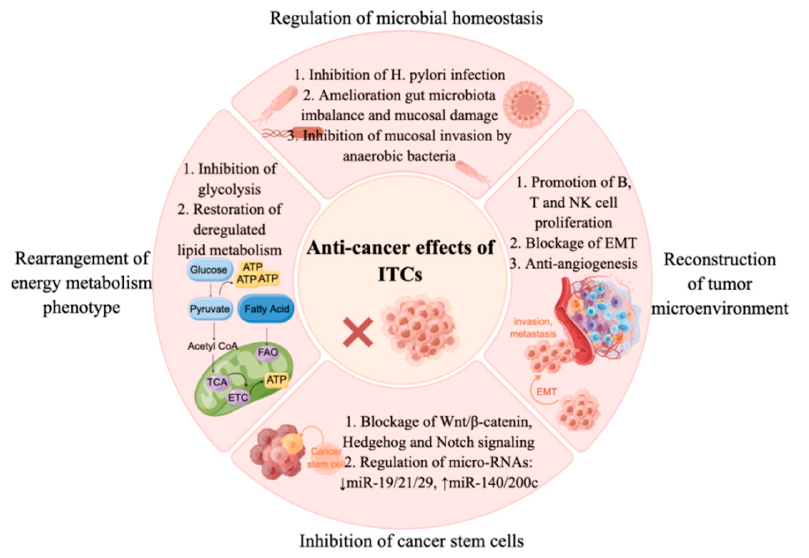
Figure 1. Multiple mechanisms of isothiocyanates in cancer prevention and therapy. ITCs inhibit cancers through regulating microbial homeostasis, such as inhibiting H. pylori infection, ameliorating gut microbiota imbalances and mucosal damage, and inhibiting mucosal invasion by anaerobic bacteria. ITCs inhibit cancer cell proliferation via suppressing glycolysis, restoring deregulated lipid metabolism, and inhibiting CSCs via regulating self-renewal signaling (Wnt/ β -catenin, Hedgehog and Notch signaling) and miRNA pathways. Furthermore, ITCs exert anti-cancer effects via remodeling the tumor microenvironment, such as promoting B, T and NK cells’ proliferation, blocking EMT and inhibiting angiogenesis. ITCs, isothiocyanates; H. pylori , Helicobacter pylori ; miR, microRNAs; EMT, epithelial-to-mesenchymal transition; TCA, tricarboxylic acid cycle; ETC, electron transport chain; FAO, fatty acid oxidation; NK cell, natural killer cell.